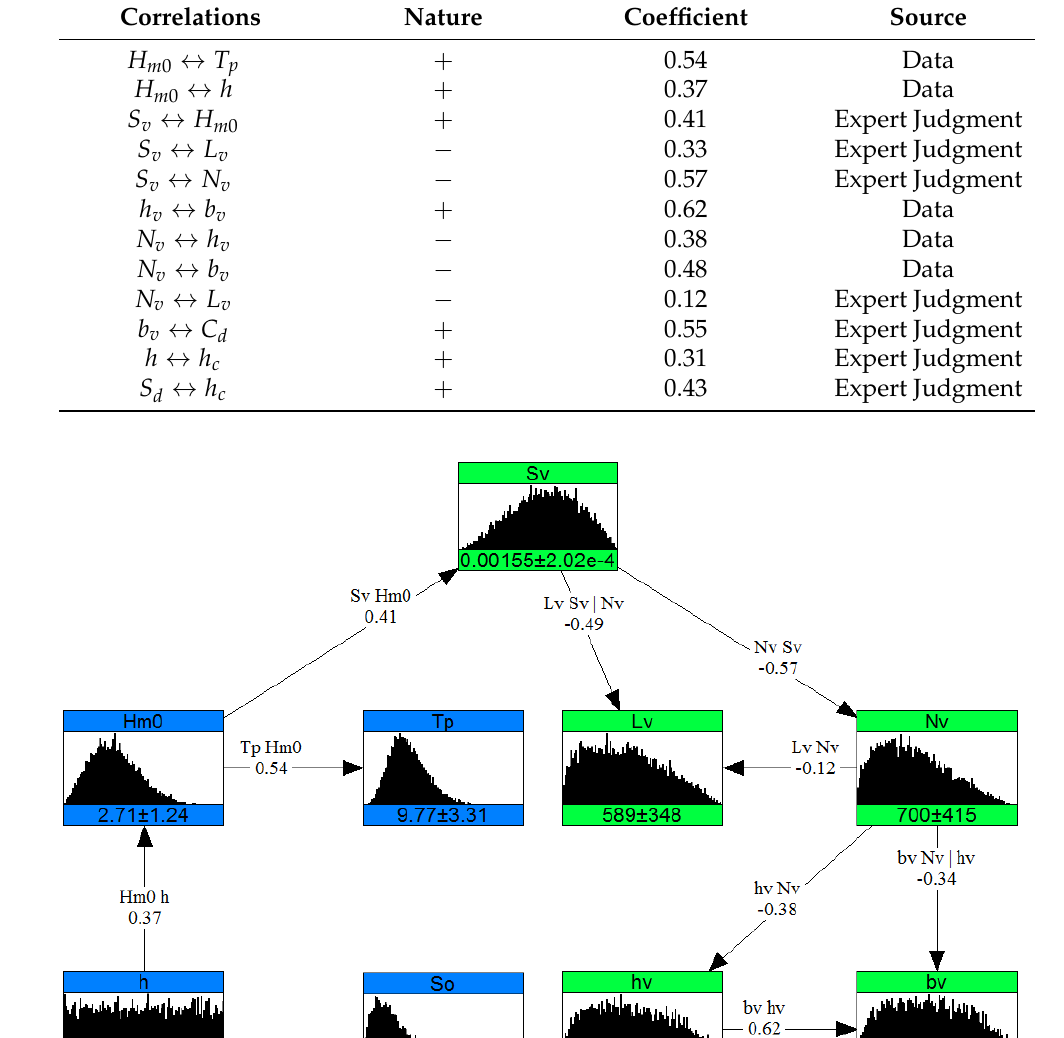
Table 4. Rank correlations among variables in salt marsh system. See Figure 9 for correlations of mangrove system variables.